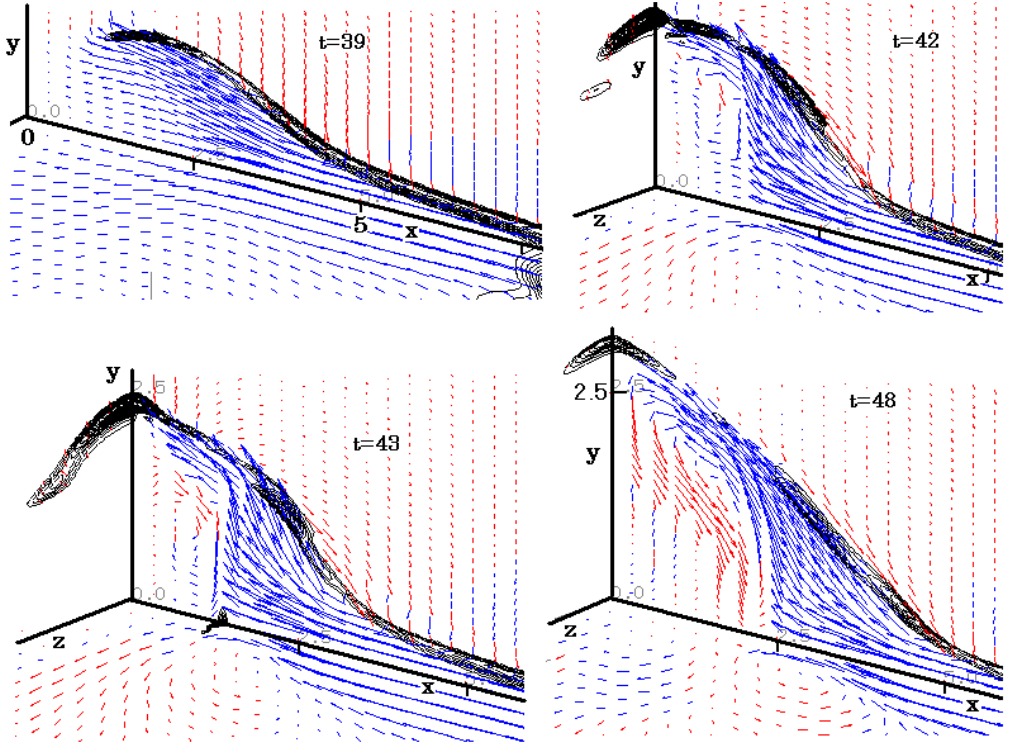
Fig. 8. Plasma flow vectors and distributions of the joule heating η J 2